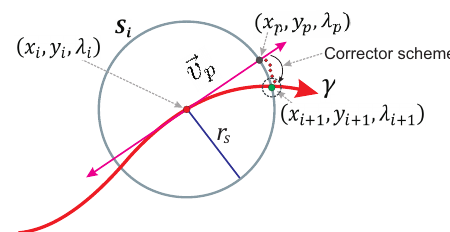
Figure 5. Corrector scheme for spherical tracking.